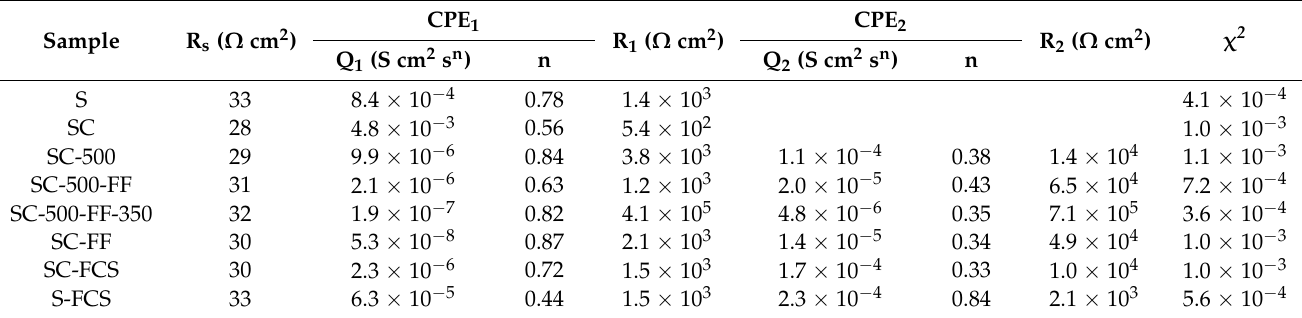
Figure 9. Equivalent electrical circuits used to fit the experimental impedance spectra of coatings S and SC ( a ) and SC-500, SC-500-FF, SC-500-FF-350, SC-FCS, SC-FF, and S-FCS ( b ). Table 3. Calculated EEC element parameters for samples with different